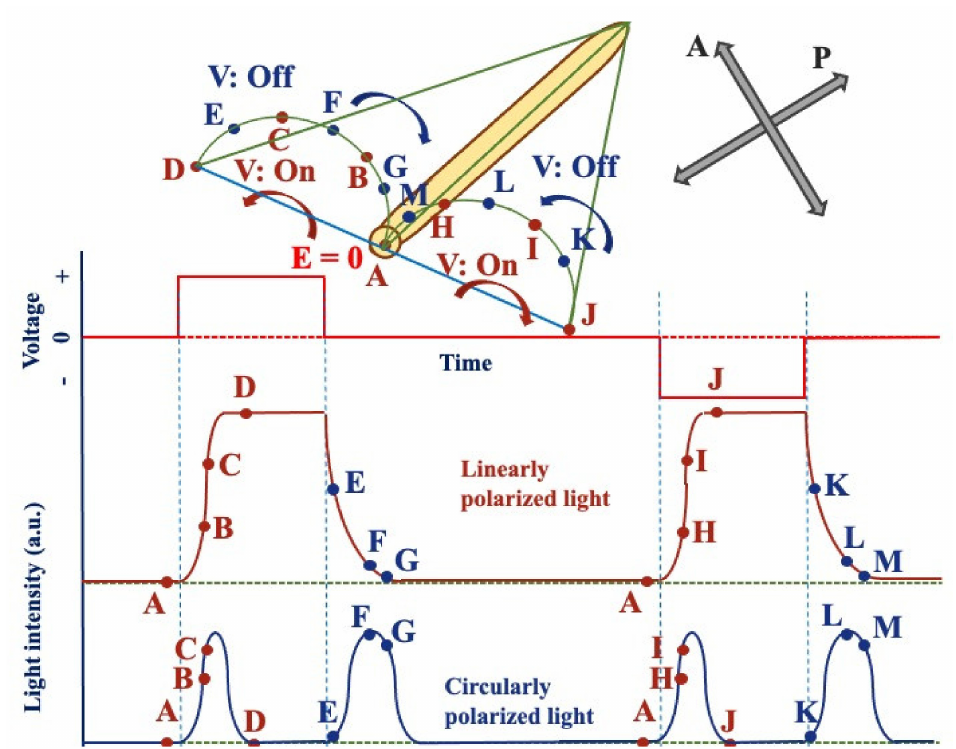
Figure 16. Liquid crystal molecular director switching model for the slightly-twisted stacked SSD-LC panel. In the slightly twisted stacked SSD-LC panel, the liquid crystal molecular director switches include out-of-plane retardation behavior.